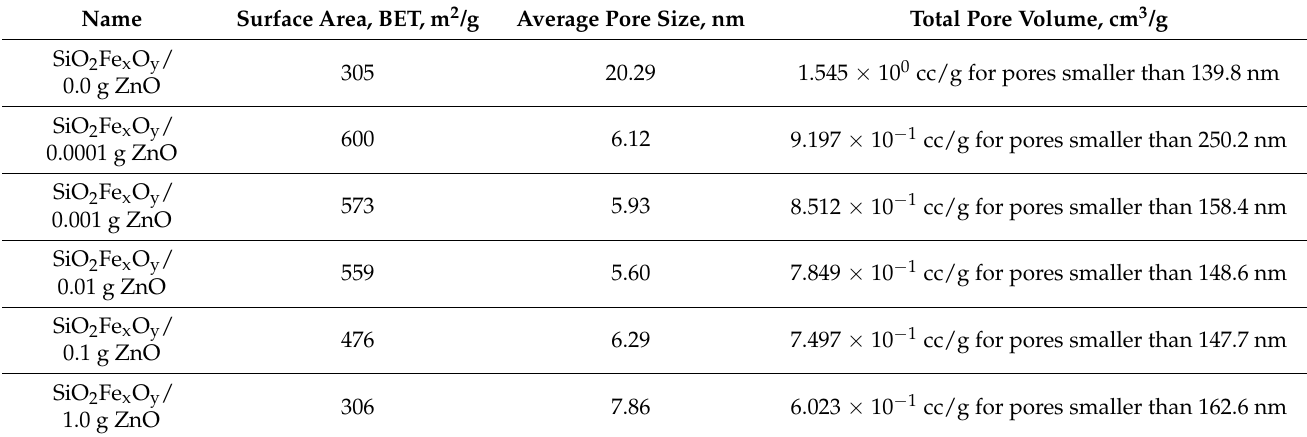
Table 1. Textural parameters from N 2 adsorption–desorption